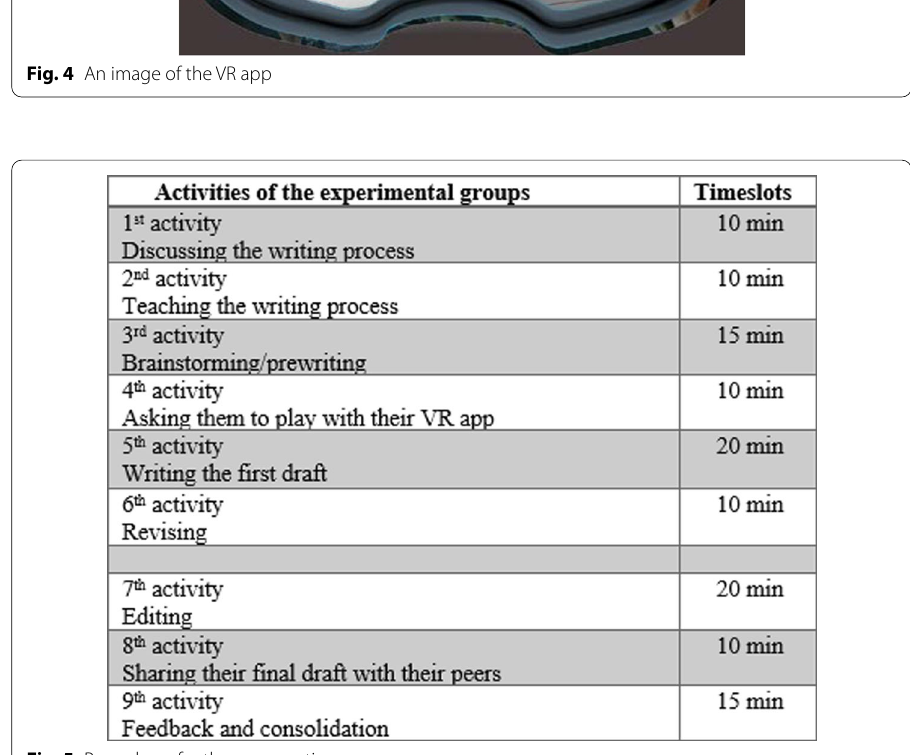
Fig. 5 Procedures for the comparative